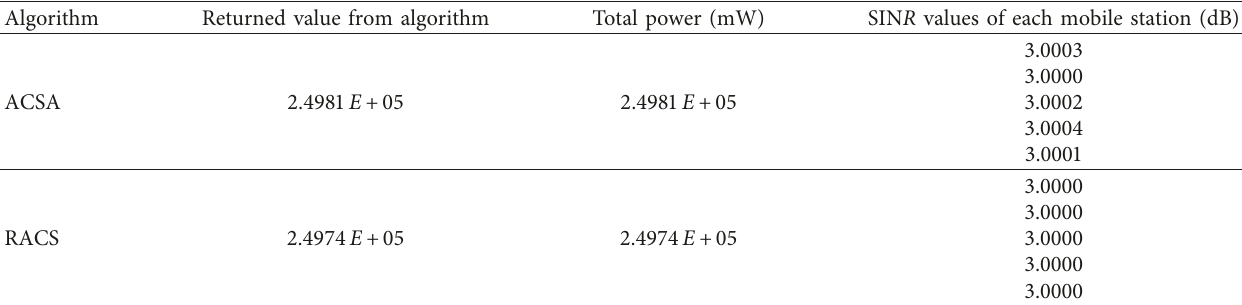
Table 12: Returned results of ACSA and other advanced optimization algorithms for scenario